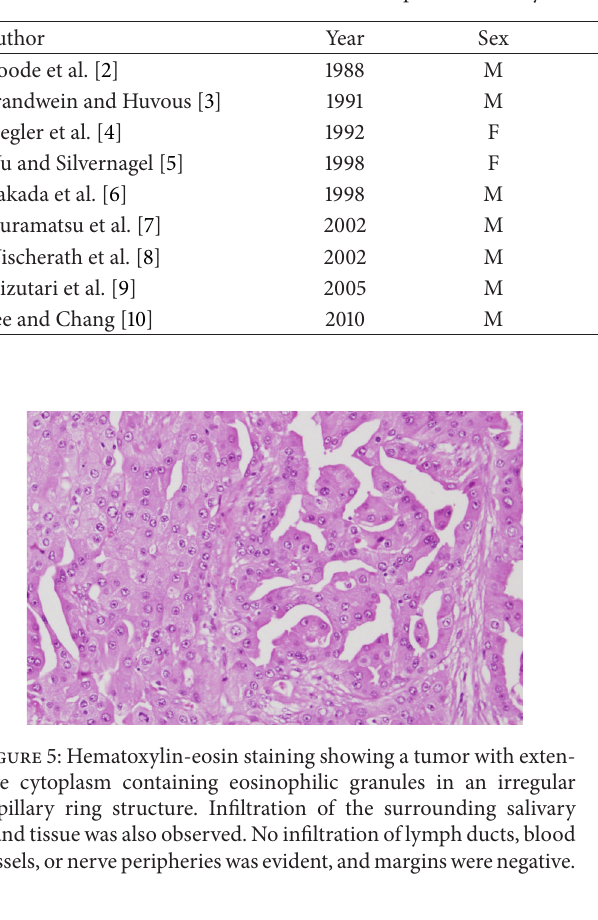
Table 1: Reports of oncocytic carcinoma in submandibular glands.